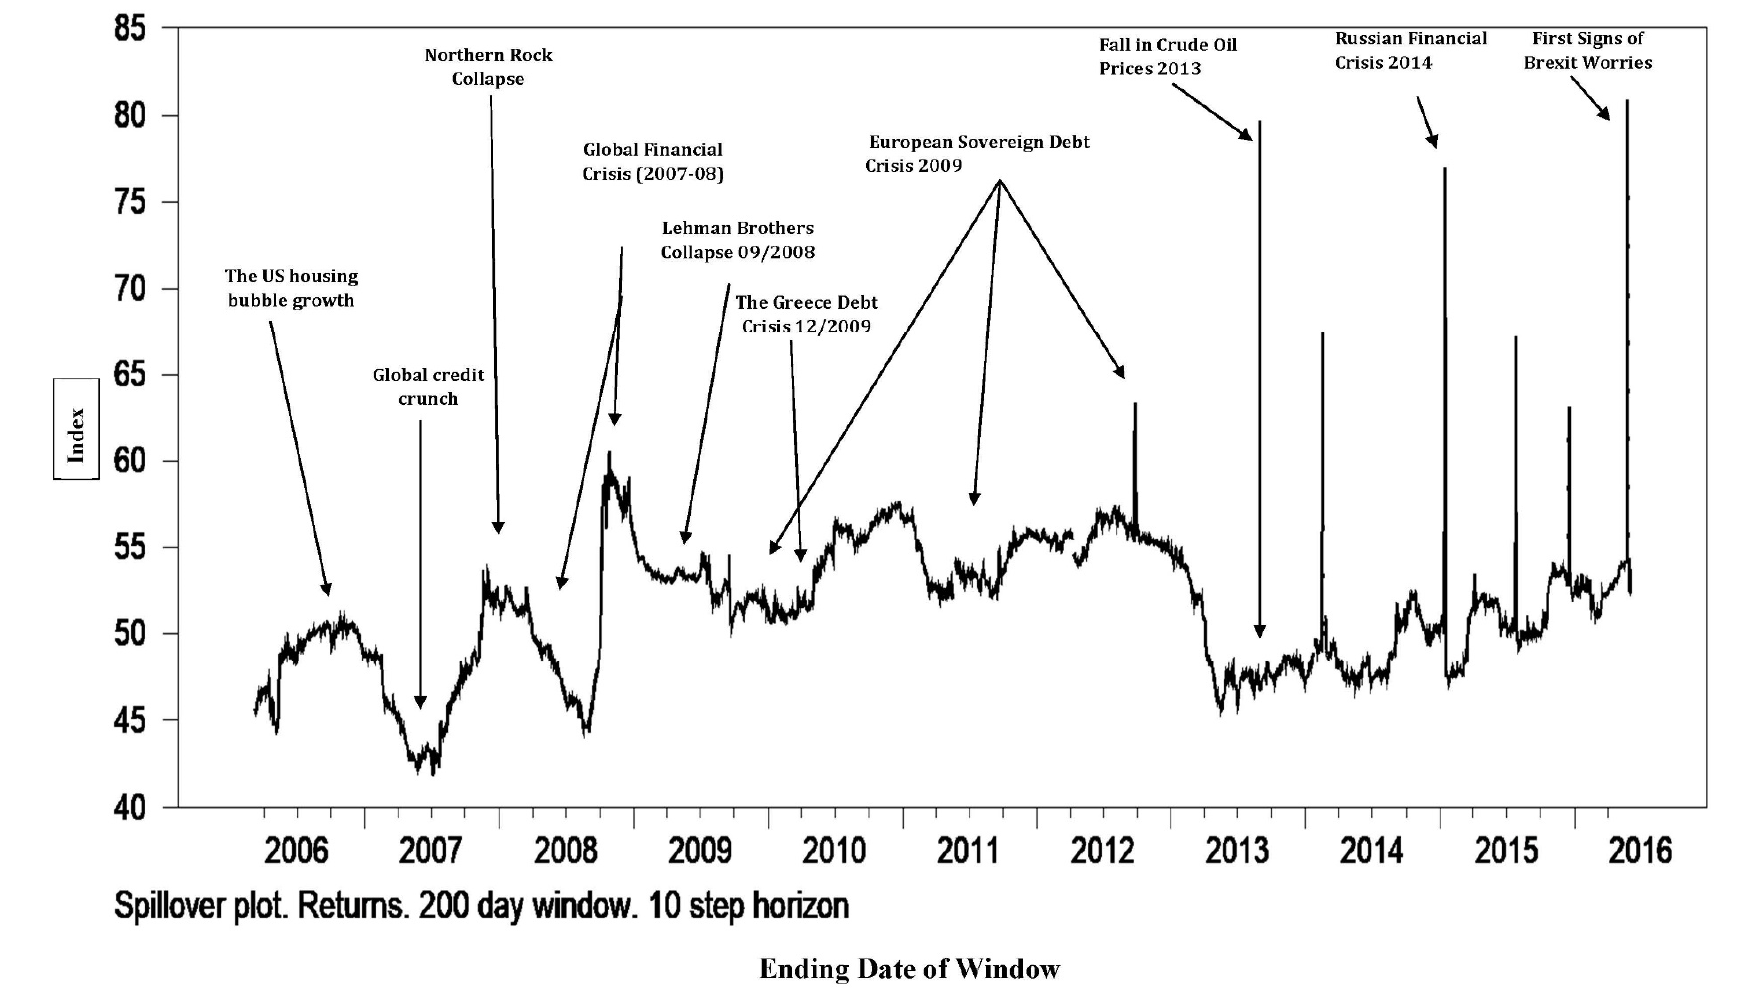
Figure 1. Spillover plot. Global foreign exchange market returns (2005–2016).